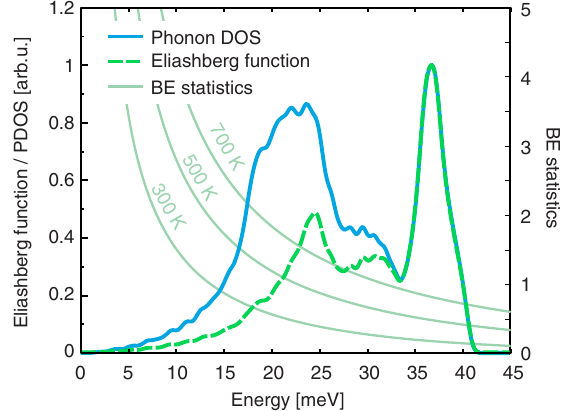
FIG. 1. Normalized phonon density of states (PDOS) and Eliashberg function of aluminium, calculated with DFT and the ABINIT package. The solid green lines show Bose-Einstein statistics for three lattice